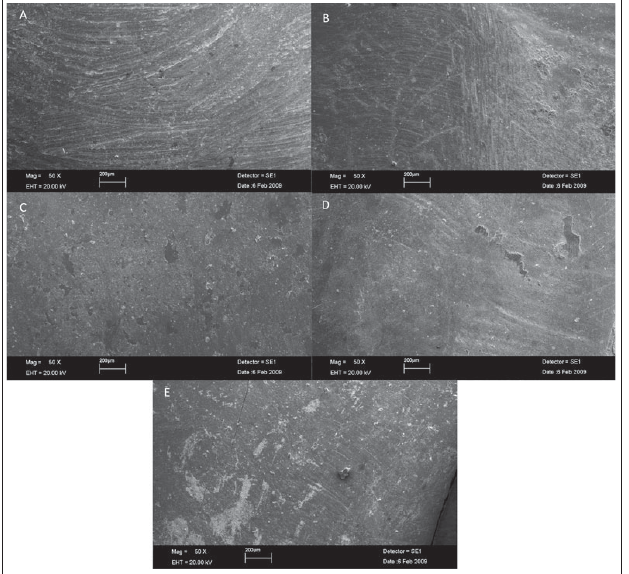
Fig. 2. Representative SEM micrographs of enamel surfaces at 50x magnification after cleaning clean-up of enamel with: A-tungsten carbide bur at high speed; B - tungsten carbide bur at low speed; C - Shofu tip at high speed; D - Shofu tip at low speed; E - Zatty 934 pliers. resin removal tested. Nonetheless, SEM lacks a quantitative scale, cannot be used for the comparative assessment, and provides only subjective information 22